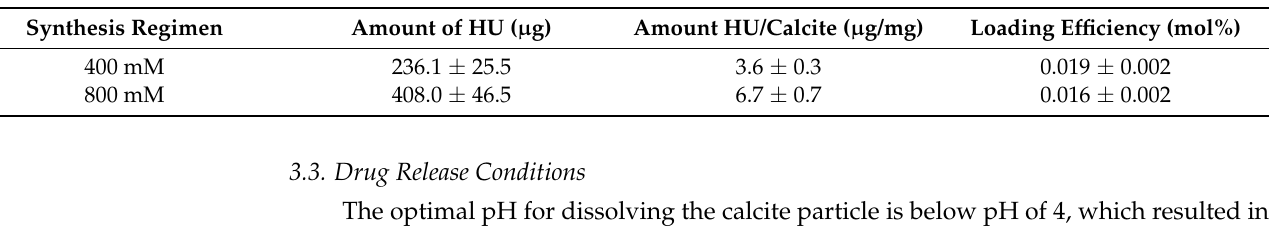
Figure 4. Amount of HU recovered after washing with water and ethanol. The particles were dis ‐ solved in 1 M HCl, (Mean ± SD, n = 3). Table 2. Summary of collected data and calculations of loading properties for the two synthesis conditions (400 mM HU and 800 mM HU).